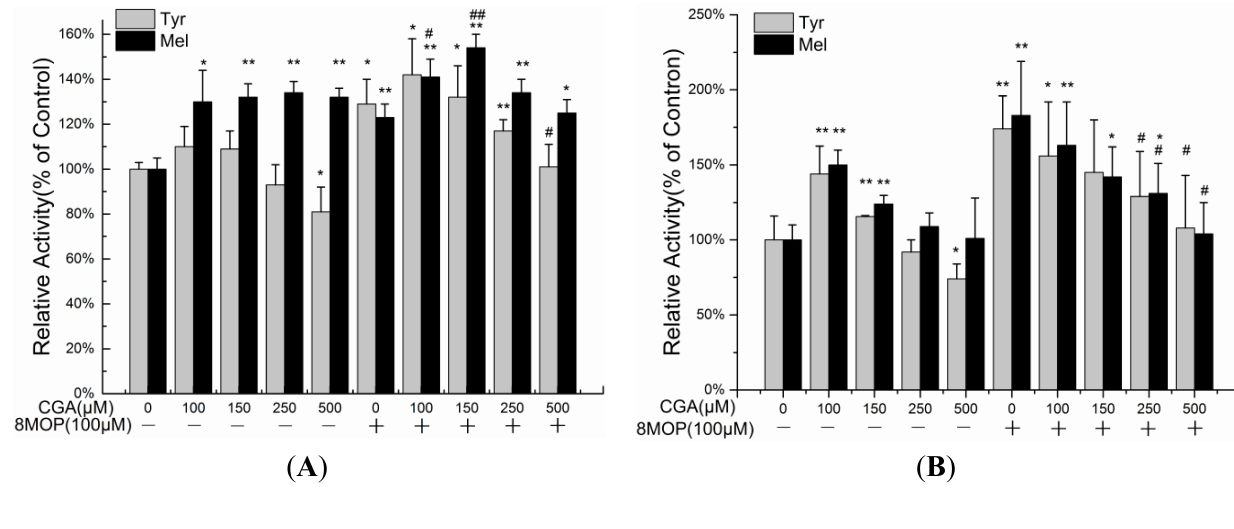
Figure 3. The effects of CGA on the melanin content (Mel) and tyrosinase activity (Tyr) of B16 melanoma cells and 8-MOP treated B16 melanoma cells, treated 24 h ( A ), 48 h ( B ).